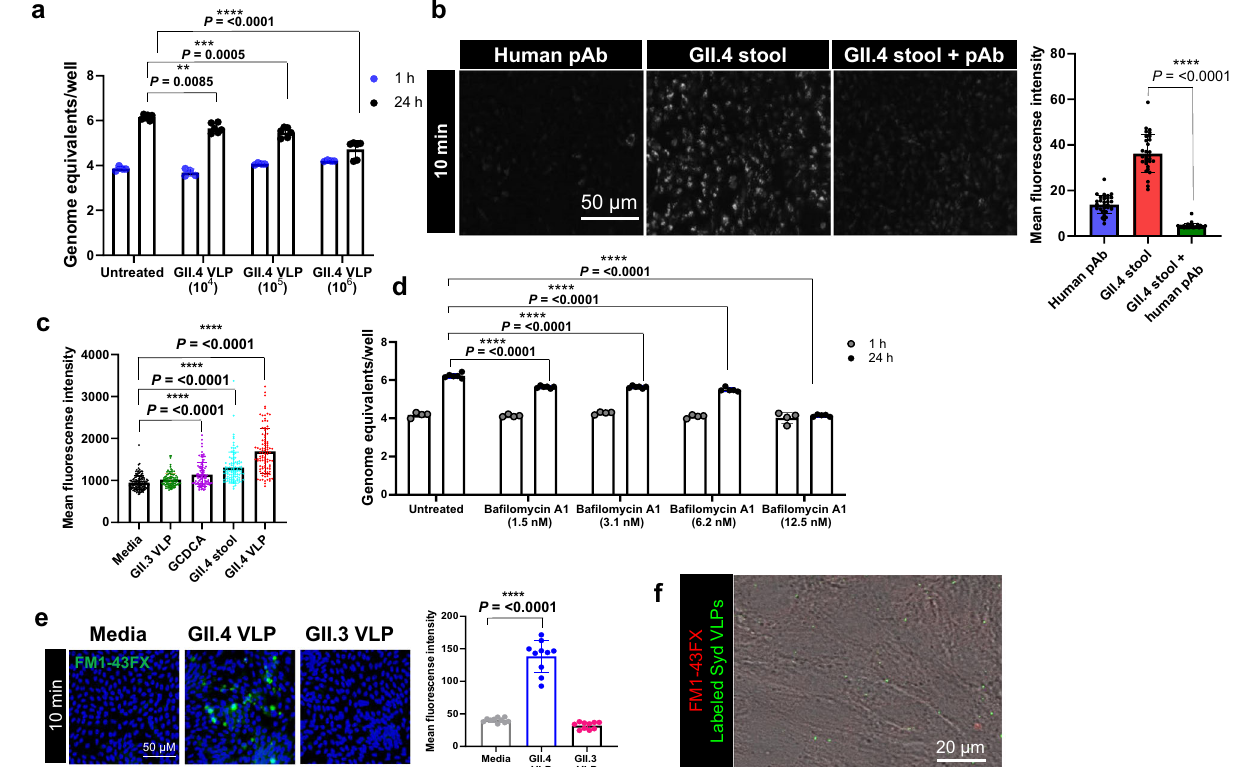
Fig. 1 | GII.4 capsid protein elicits acidi fi cation and endocytosis in HIEs. a Viral replication at 24h (black dots) compared to bound virus at 1h (blue dots) and inhibition of replication in the presence of VLPs compared to untreated at 24h. Replication was quanti fi ed using n =2 independent HIE replicates for the 1h and n =3 independent HIE replicates for 24h with 2 technical replicates/sample. b LysoTracker staining of acidic compartments in the presence of an anti-GII.4 polyclonalantibody(pAb),GII.4virus,andpAbmixedwithGII.4virusat37 o C.Right panel:Mean fl uorescenceintensitywasquanti fi edfromdifferentregionsofinterest (ROIs)forpAb(bluebar,ROIs=32),GII.4stool(redbar,ROIs=31),GII.4stool+pAb (green bar, ROIs=32). c LysoTracker staining of acidic compartments induced by GII.3 VLP (green, ROIs=100), GCDCA (purple, ROIs=100), GII.4 virus (cyan, ROIs=101), and GII.4 VLP (red, ROIs=97) compared to media (black, ROIs=140).